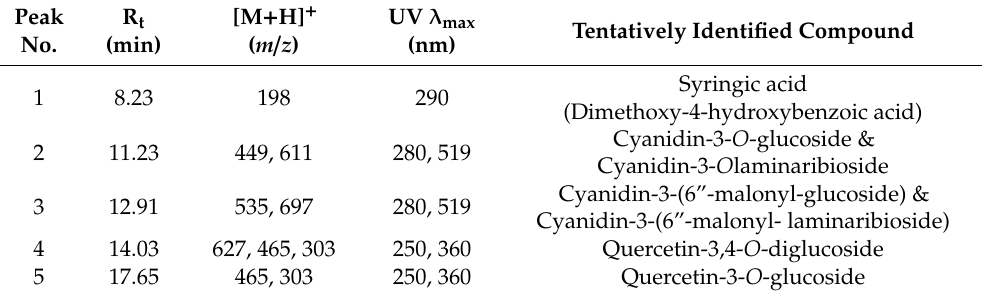
Table 4. Characterization of phenolic compounds in red onion via positive